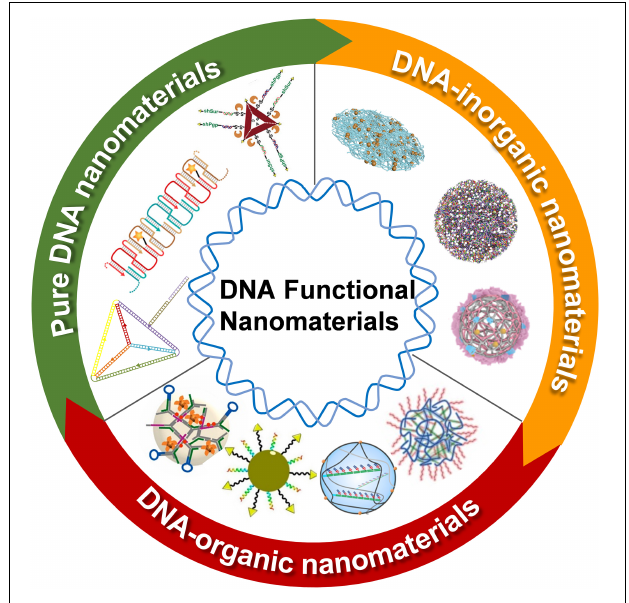
FIGURE 1 | Schematic illustration of DNA functional nanomaterials for nucleic acid-based drugs delivery. DNA functional nanomaterials were developed into three major categories: pure DNA nanomaterials (marked with green), DNA-inorganic nanomaterials (marked with orange), and DNA-inorganic nanomaterials (marked with red). Images in pure DNA nanomaterials section (clockwise); Adapted with permission from Lee et al. (2012). Adapted with permission from Chen et al. (2015). Copyright 2015, American Chemical Society. Adapted with permission from Liu et al. (2018). Copyright 2018, Wiley-VCH. Images in DNA-inorganic nanomaterials section (clockwise); pure DNA nanomaterials (clockwise); Adapted with permission from Huo et al. (2019). Adapted with permission from Li M. et al. (2019). Copyright 2019, Wiley-VCH. Adapted with permission from Wang et al. (2021). Copyright 2021, Wiley-VCH. Images in DNA-organic nanomaterials section (clockwise); Adapted with permission from Ding et al. (2018). Copyright 2018, Wiley-VCH. Adapted with permission from Li et al. (2021). Copyright 2021, Nature Publishing Group. Adapted with permission from Liu et al., 2019. Copyright 2019, American Chemical Society. Adapted with permission from Han et al. (2021a). Copyright 2021, Elsevier Publishing